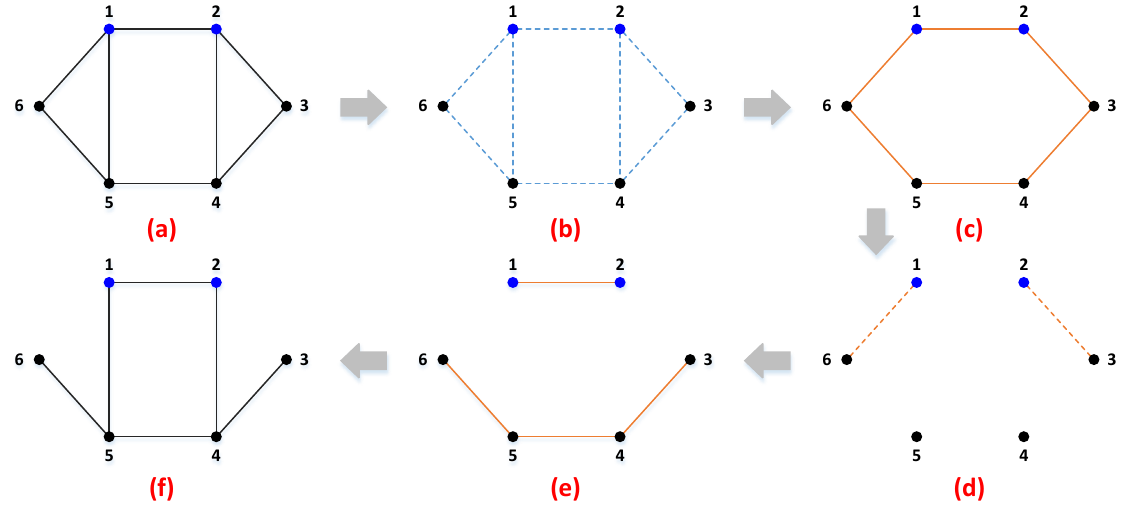
Figure 2. Demonstration of deception strategies in power system fortification: ( a ) original power system; ( b ) candidate deception branch set; ( c ) deceived power system shown to the adversary; ( d ) deliberate attack plan; ( e ) expected power system by the terrorist after attack; ( f ) actual power system after attack.